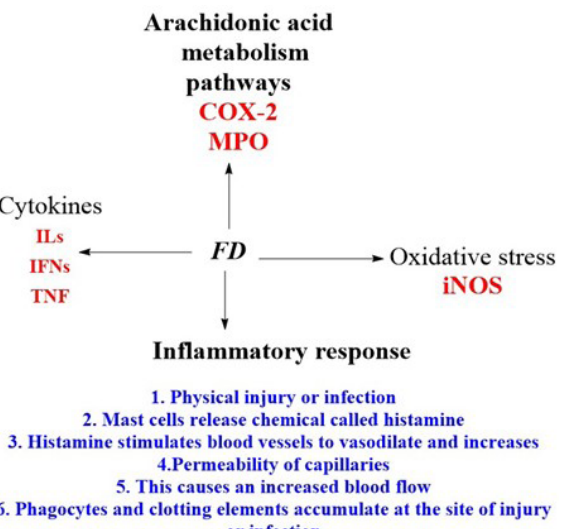
Figure 3. Anti-inflammatory mechanisms of action of F. deltoidea crude extract or pure compounds. MPO: myeloperoxidase; IFNs: interferons; iNOS: inducible NOS Effects on